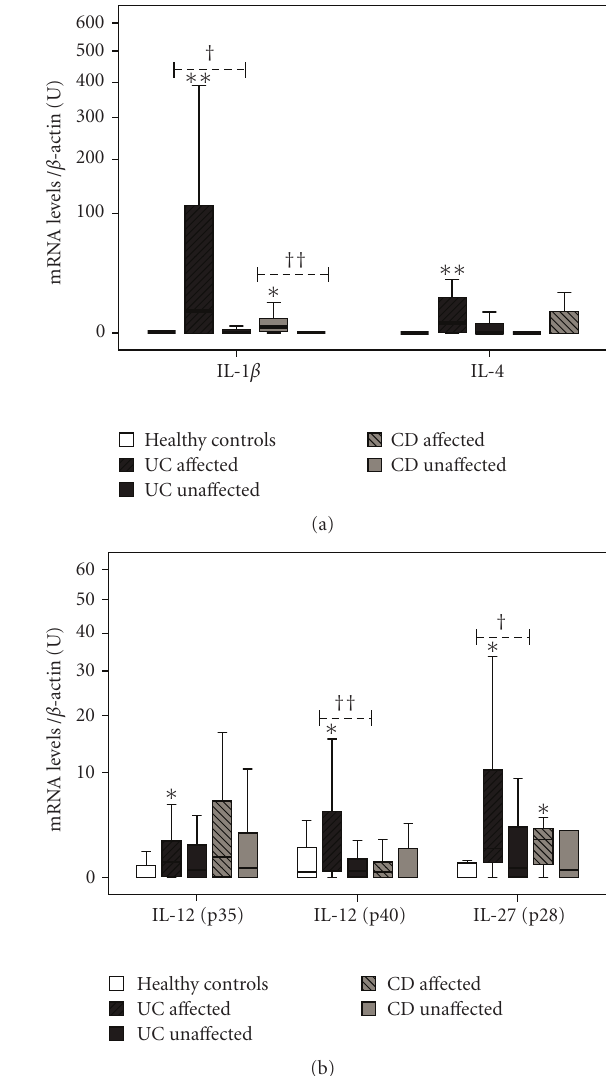
Figure 2: Di ff erences in mRNA levels of cytokines increased only in both a ff ected and una ff ected areas of IBD. Statistical di ff erences compared to healthy controls ∗ P < . 05 and ∗∗ P < . 001, and between a ff ected and una ff ected areas from the same pathology † P < . 05 . U: arbitrary units.